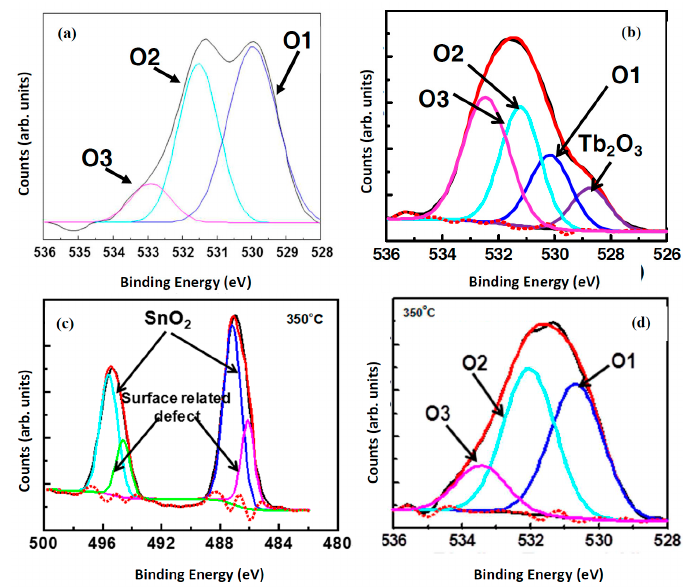
Figure 11. De-convolution of the O-1s peak of: ( a ) defect containing ZnO [4]; ( b ) ZnO with 6 mol % doping of Tb [45]; ( c ) Sn-3d 5/2 and Sn-3d 3/2 peaks of SnO 2 ; and ( d ) O-1s of SnO 2 [55].